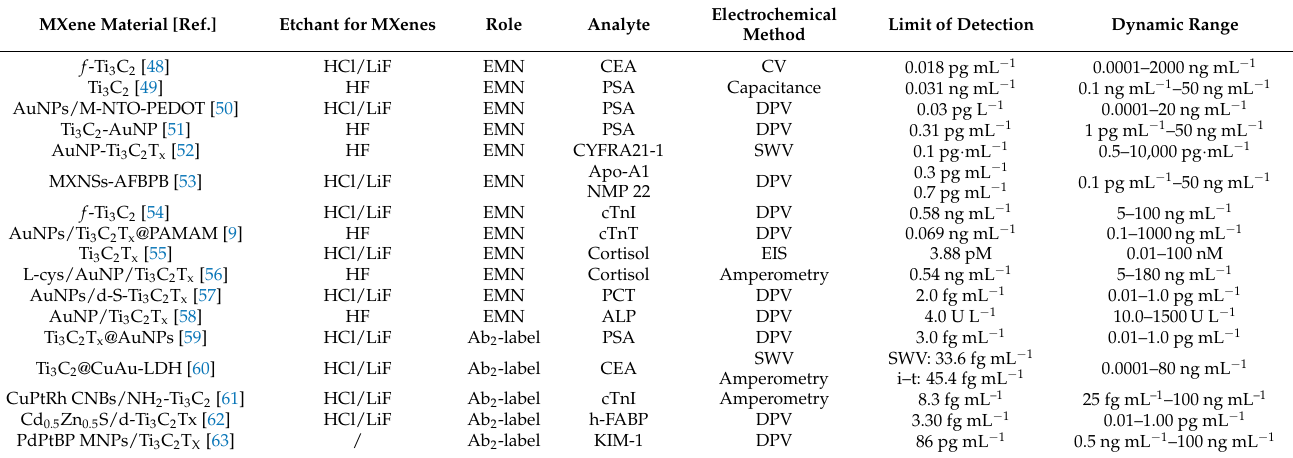
Table 1. Electrochemical immunosensors based on